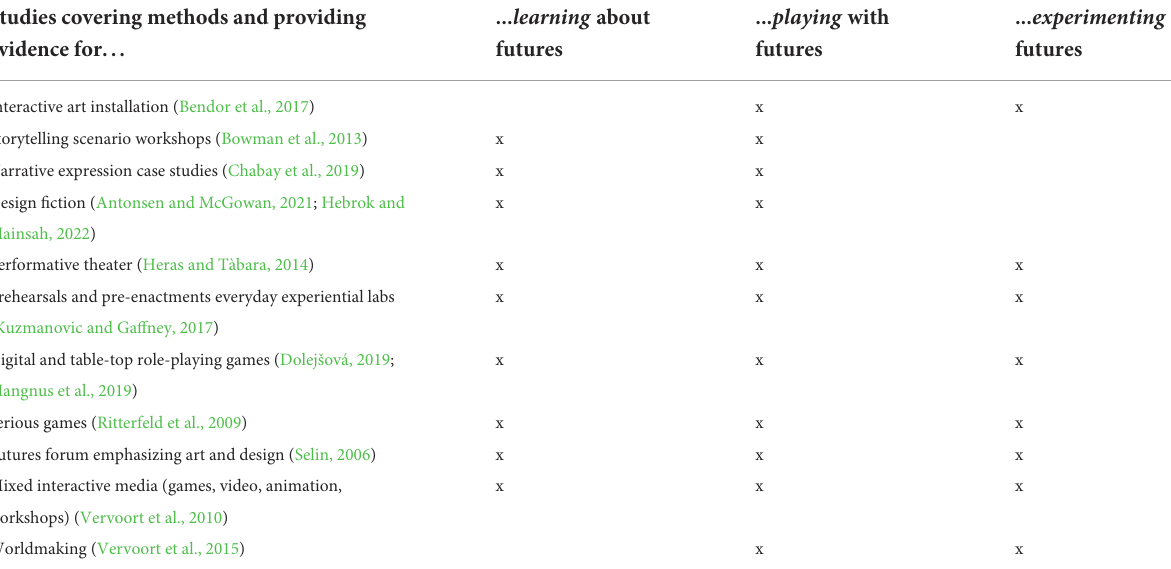
TABLE 1 Examples of soft scenario methodologies and how they encourage learning, play, and experimentation with futures (adapted from McGreevy et al., 2021). Studies covering methods and providing evidence